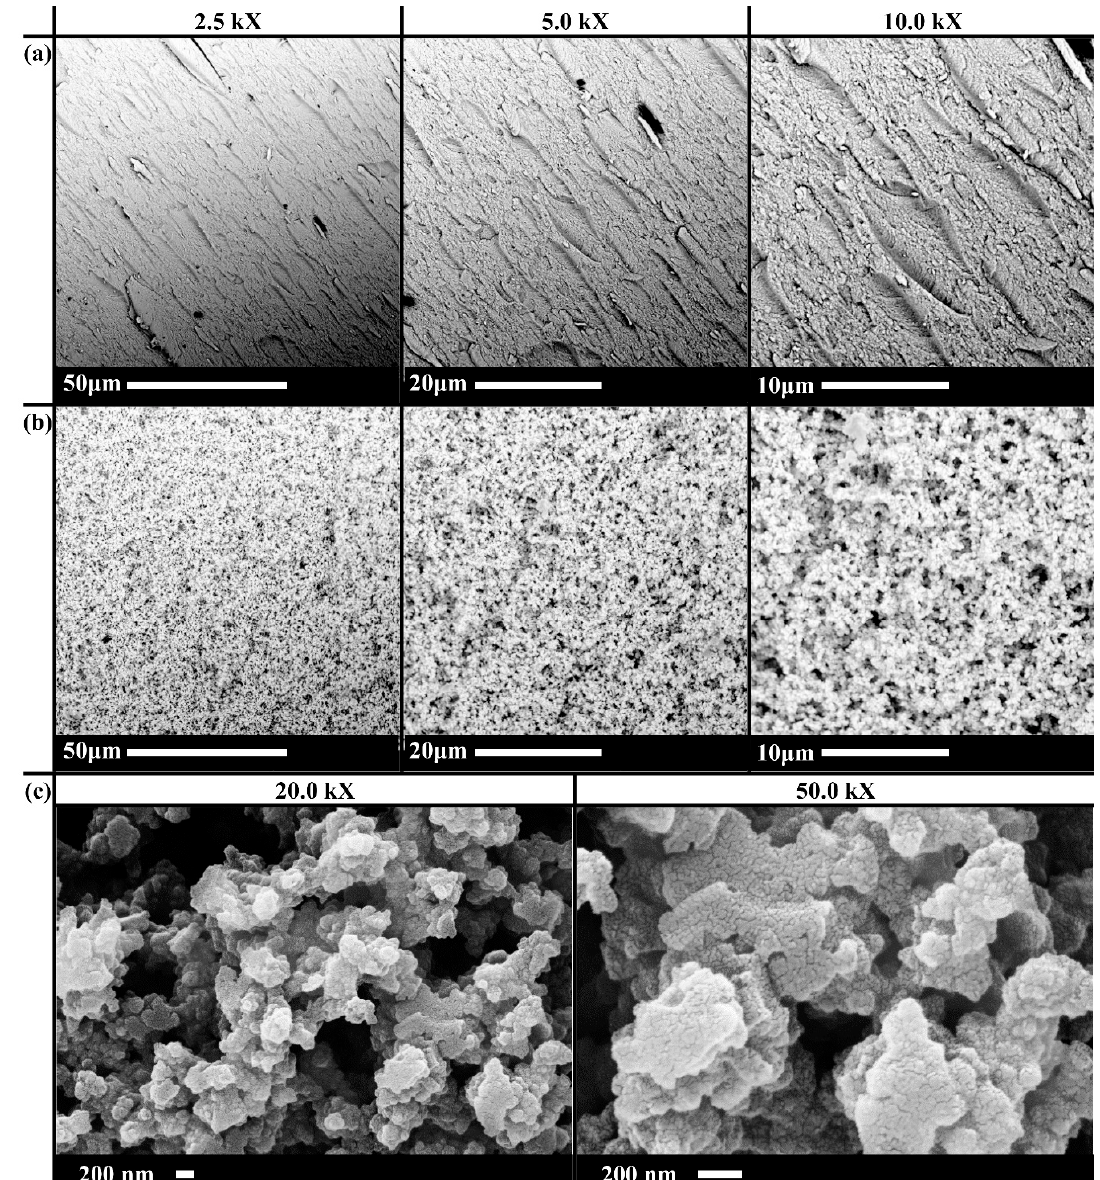
Figure 4. ( a ) SEM images of the product with maximum shrinkage (sample number 15) ( b ) SEM images of the product with minimum shrinkage (sample number 2). ( c ) FESEM images of the activated carbon xerogel at different zoom levels.